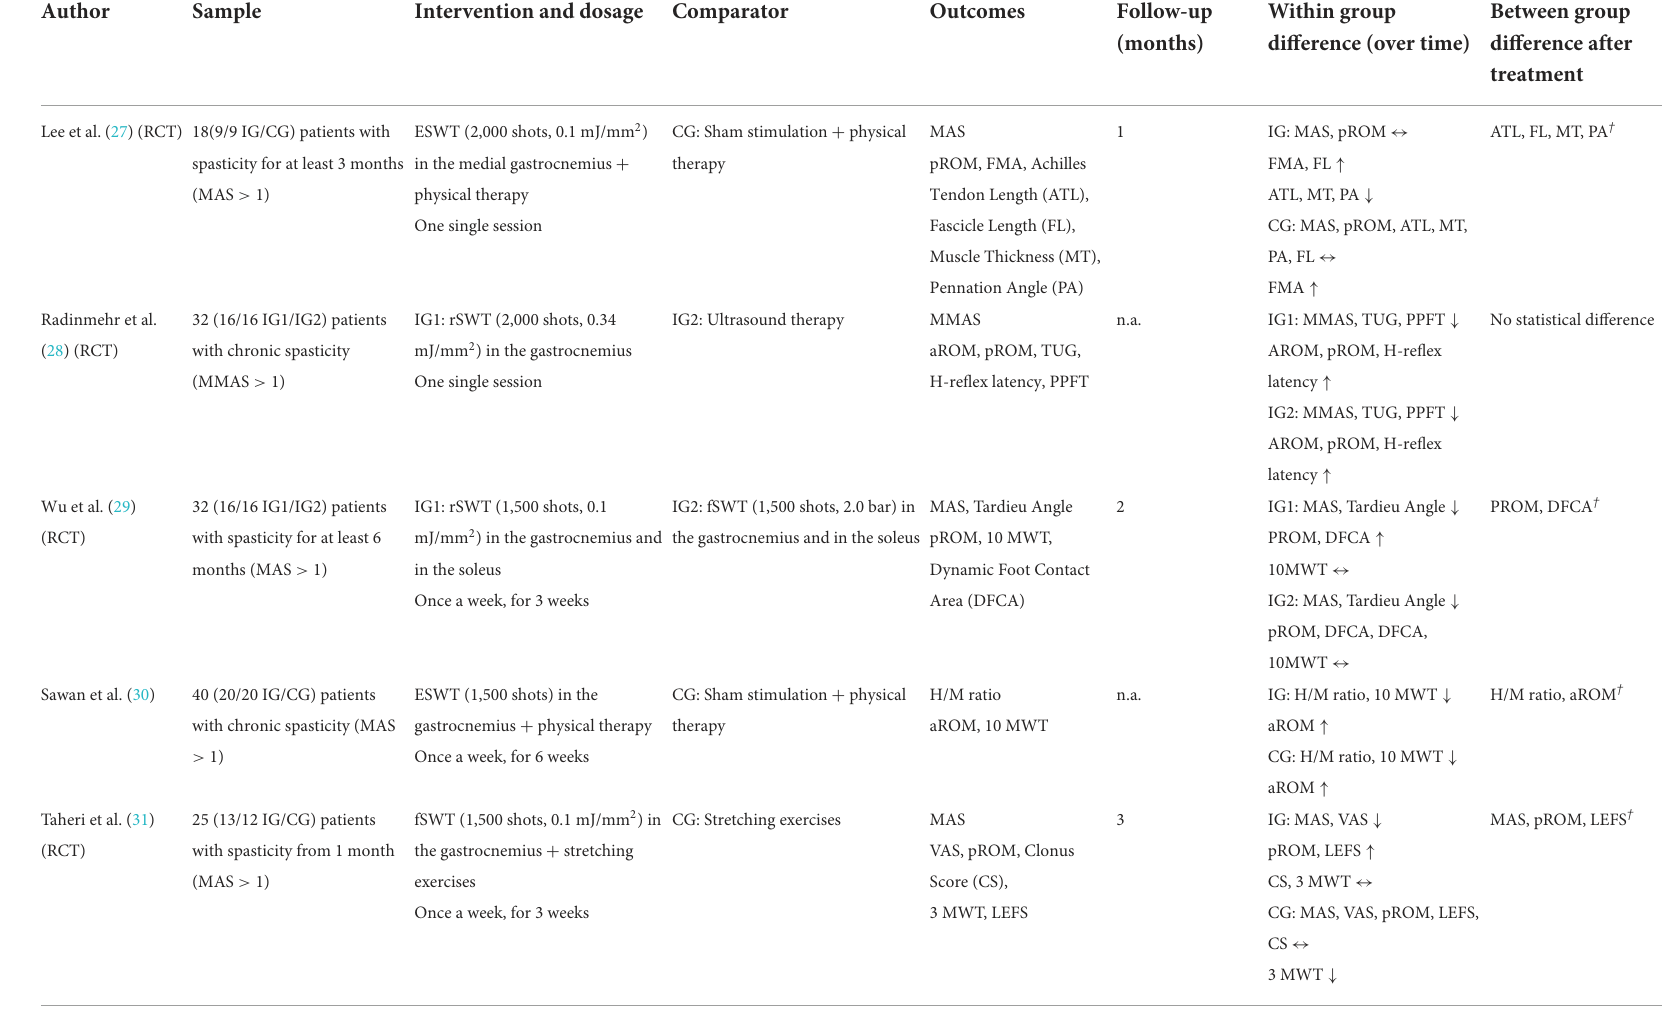
TABLE 2 Characteristics of studies using shock waves for the treatment of triceps spasticity after